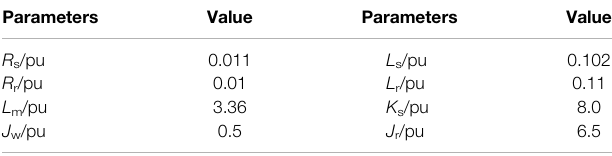
TABLE 1 | The parameters of the 2 MW PMSG.